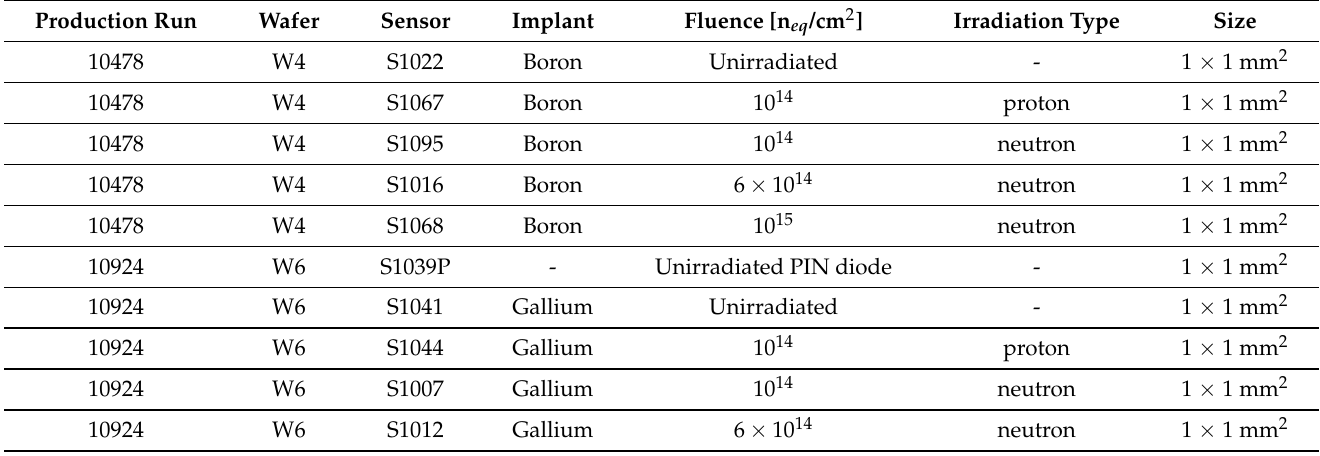
Table 2. List of the studied